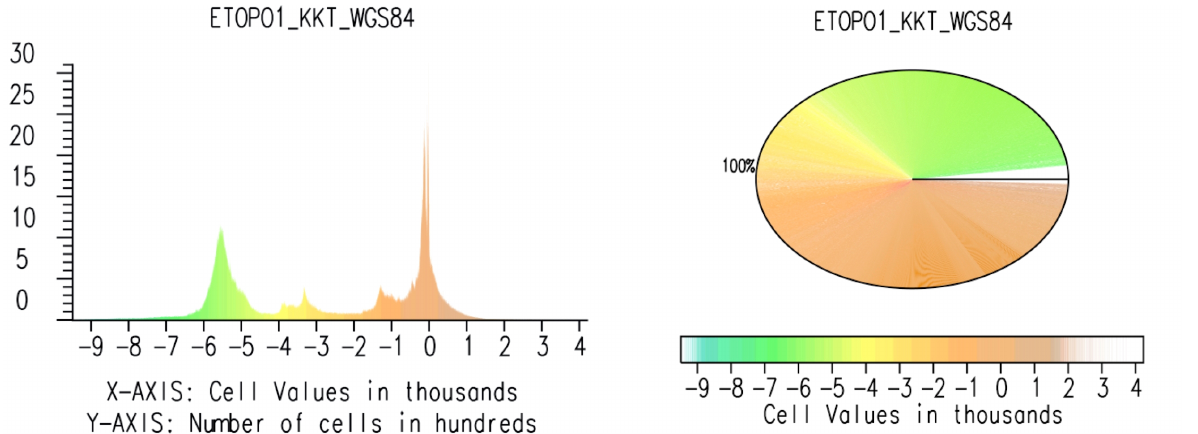
Figure 7. Bar graph histogram for elevation map ( left ); pie graph of height distribution based on the raster grid ETOPO1 ( right ). Source: